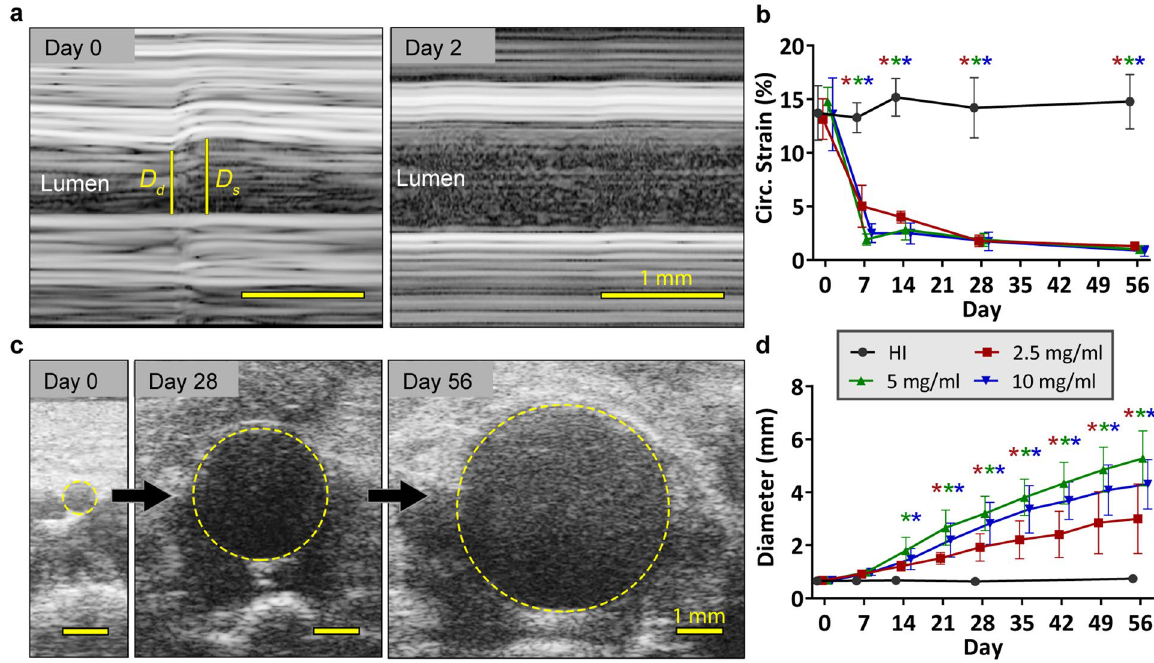
Figure 2. Longitudinal ultrasound imaging of elastase-treated mice. ( a ) Measurements of diastolic and systolic diameters from ultrasound M-mode images were used to calculate Green–Lagrange circumferential strain. ( b ) Post-elastase application, mice showed significantly reduced circumferential strain compared to both baseline measurements and to the heat-inactivated group. In addition, mice treated with 2.5 mg/ml (red) elastase had significantly higher strain than the 5 (green) and 10 mg/ml (blue) groups on day 7. By day 14, measures of strain were indistinguishable among the elastase-treated groups, and remained low for the remainder of the study. ( c ) Short-axis measures of diameter show a continuously increasing aneurysm. ( d ) While all mice had aneurysms, the mice treated with 5 and 10 mg/ml elastase had significantly larger aneurysms than the mice treated with 2.5 mg/ml, beginning at days 21 and 28, respectively. Scale bars are 1 mm. Note that for clarity, the only statistical comparison shown in the graphs are relative to the baseline within each group ( p < 0.05 with the color of the ‘*’ indicating the